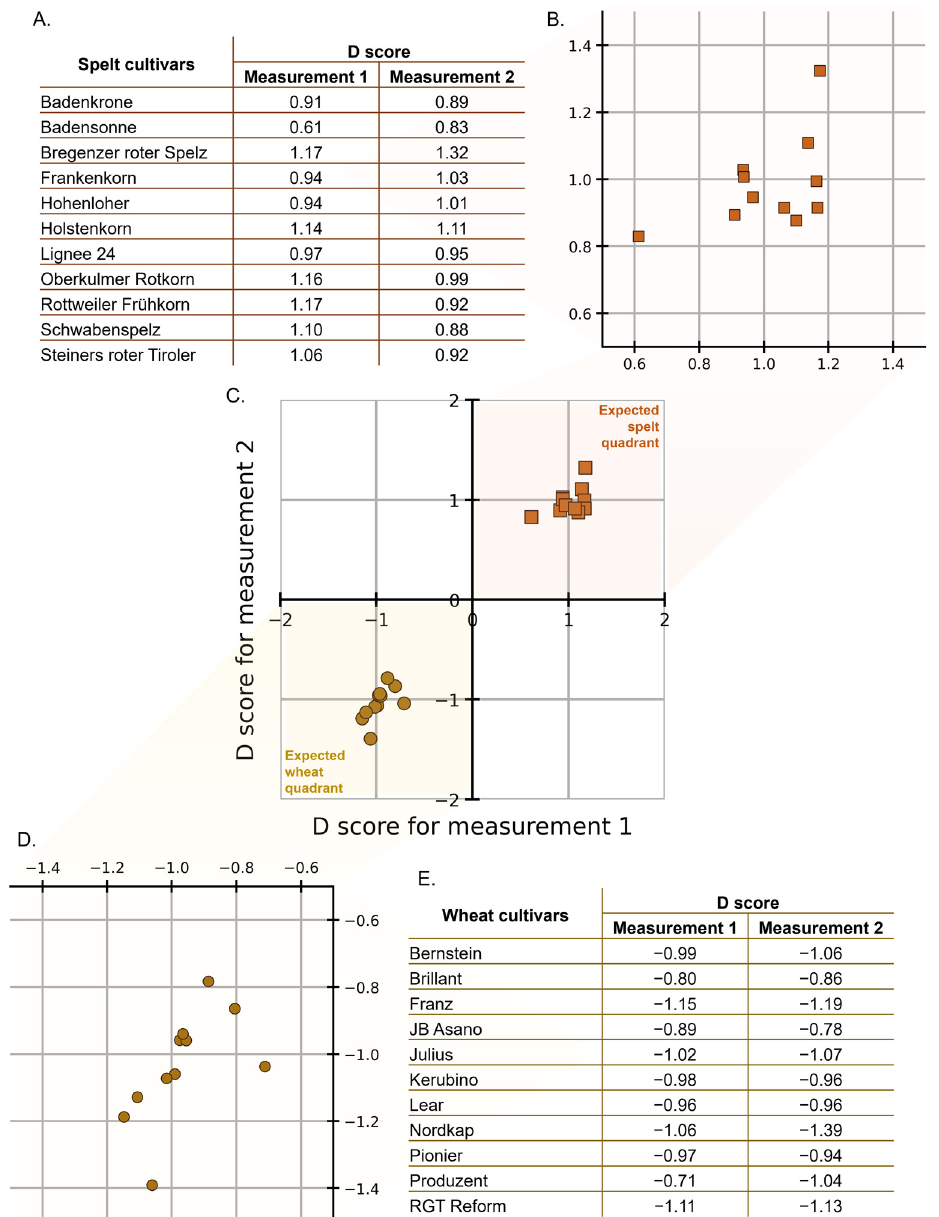
Figure 2. The D scores for the spelt cultivars (orange squares) and for wheat cultivars (brown circles) in the calibration set are plotted. ( A ) List of spelt cultivars along with their D scores. ( B ) A magnified view of the Youden plot for spelt cultivars. ( C ) Youden plot with the D scores. ( D ) A magnified view of the Youden plot for wheat cultivars. ( E ) List of wheat cultivars along with their D scores. The lack of any overlap between the point clouds directly shows the high discrimi- scores, when a D score is positive for both measurements, it lies in the first quadrant (top right) and is predicted to be spelt. Likewise, when it is negative for both D scores, it lies